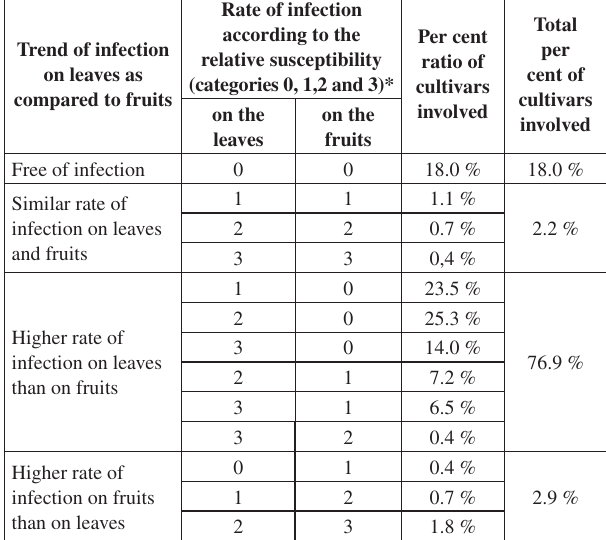
Higher rate of infection on